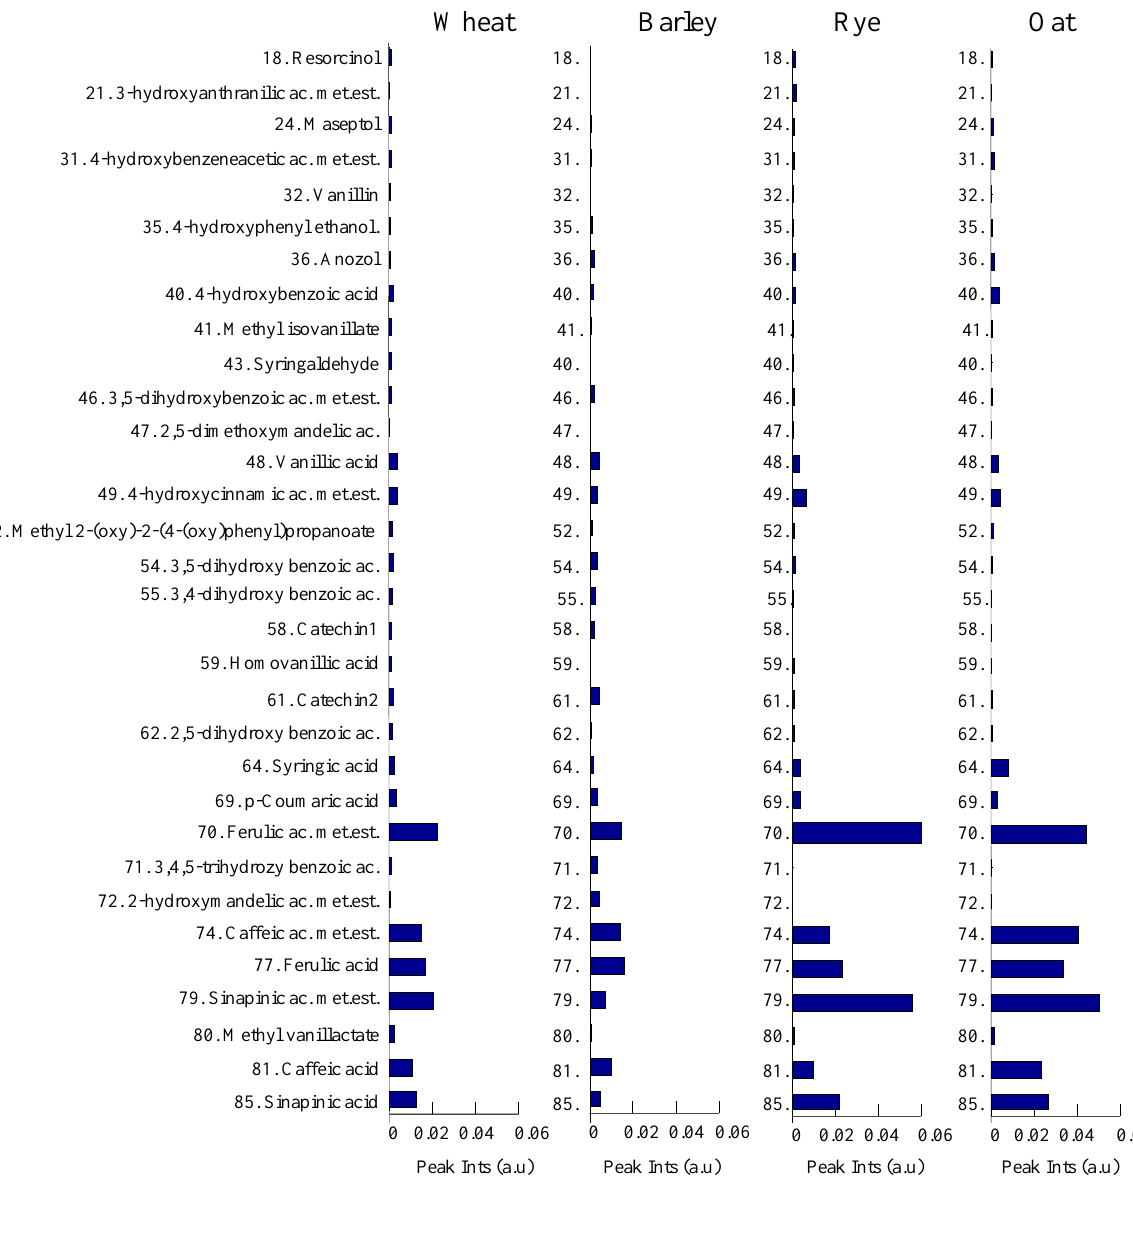
Figure 5. Relative concentrations of 32 phenolics detected from wheat, barley, rye and oat. Metabolites are numbered according to the Table